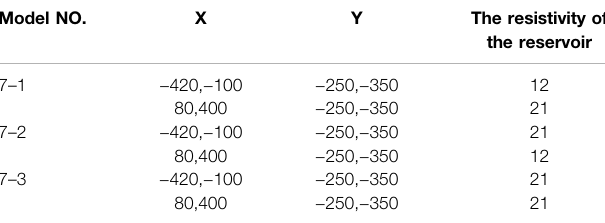
20 TABLE 8 | The model parameters of various horizontal distribution combination